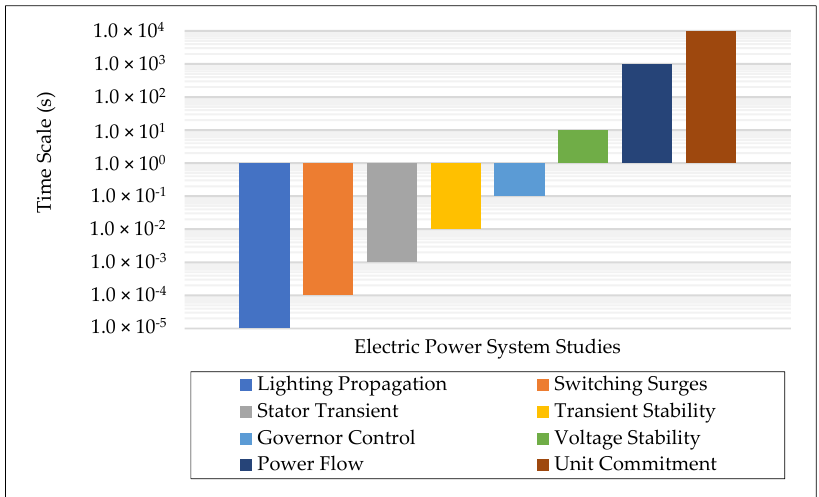
Figure 1. Time scales for electric power system studies (Based on [7]).